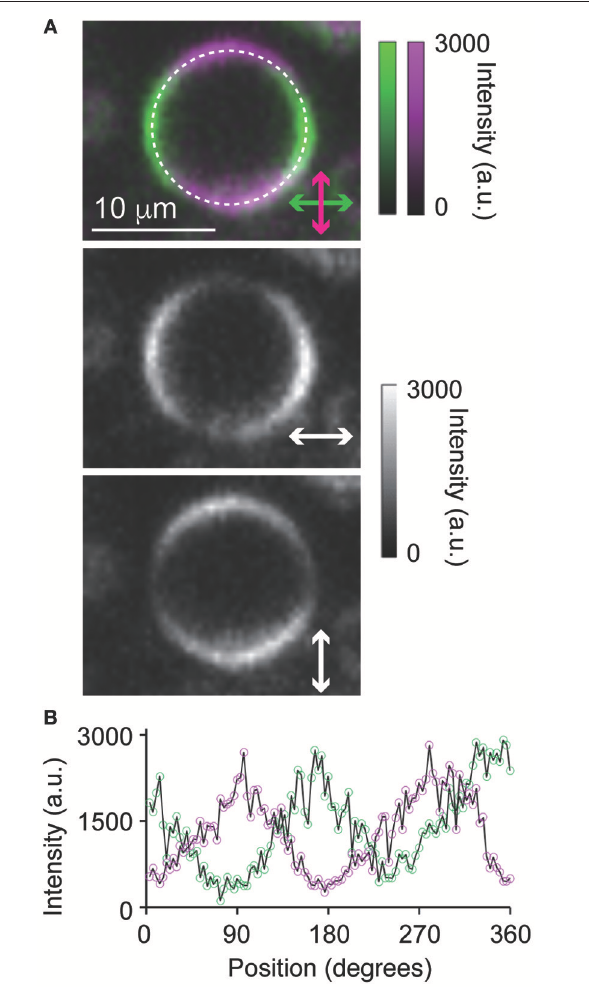
FIGURE 3 | (A) Polarization-resolved, two-photon excitation fluorescence images of a liposomal vesicle labeled with FM4-64 and excited by circularly polarized light pulses. (B) The intensity profiles of the polarization-resolved, two-photon excitation fluorescence extracted from (A) along the white, dashed circle. The exposure time was 300ms, the pixel size was 230nm × 230nm, and the FOV size was 23 µ m × 18 µ m (98 pixels × 77 pixels).